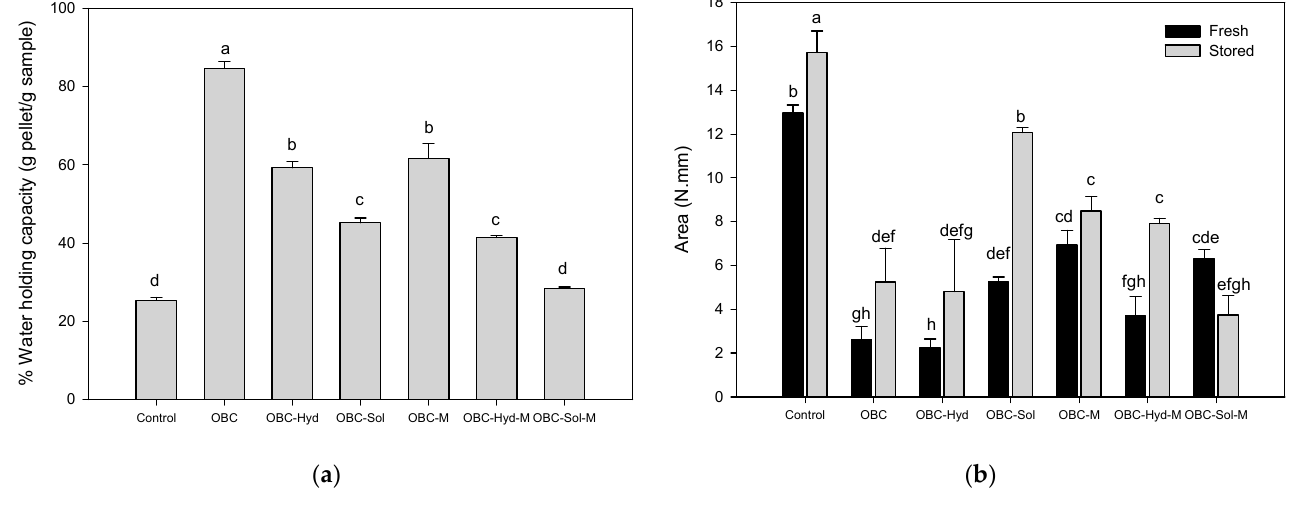
Figure 5. Water holding capacity (g pellet/g sample, %) ( a ) and firmness (area, N.mm) (fresh and 7 days stored) ( b ) of acid milk gels enriched with OBC samples and the control sample. Control = acid milk gel prepared only with skim milk powder (no oat samples added). Different letters (a–h) indicate statistically significant differences ( p < 0.05) between the samples. OBC: Oat bran concentrate; OBC-Hyd: OBC hydrolyzed with β -glucanase; OBC-Sol: water-soluble fraction from OBC after hydrolysis with β -glucanase; OBC-M: OBC microfluidized; OBC-Hyd-M: OBC-Hyd microfluidized; OBC-Sol-M: OBC-Sol microfluidized.